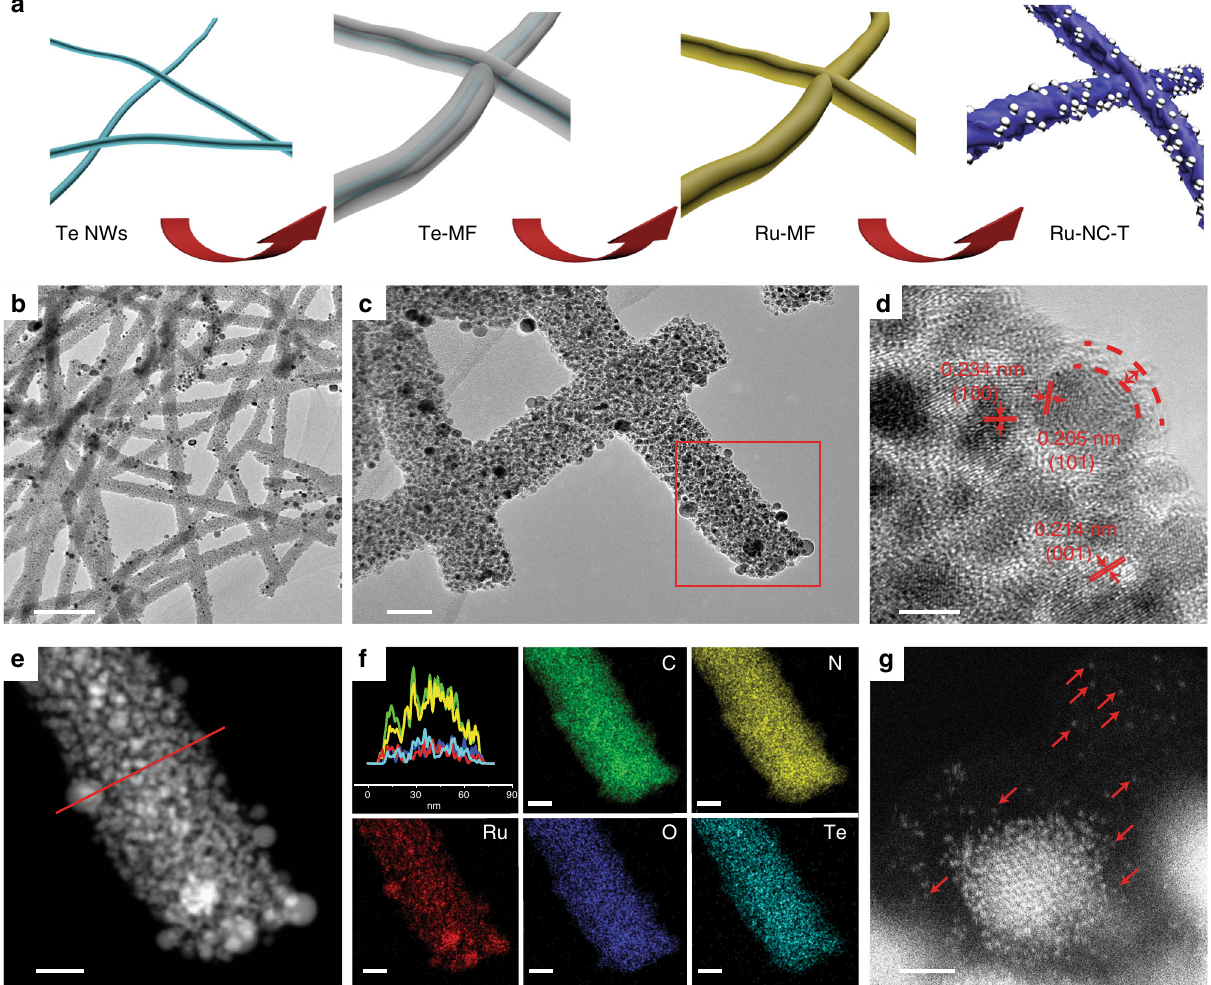
Fig. 1 Schematic of sample preparation and transmission electron microscopic (TEM) studies. a Synthetic procedure of the Ru-NC- T samples. Te NWs denotes tellurium nanowires, Te@MF refers to tellurium nanowires with a melamine – formaldehyde resin shell, Ru-MF indicates the incorporation of ruthenium precursors into Te@MF, and Ru-NC- T signi fi es Ru,N-codoped carbon prepared by pyrolysis of the Ru-MF nanowires at different temperatures. b – d Representative TEM images of Ru-NC-800 at different magni fi cations. Scale bars are b 500 nm, c 50 nm, and d 5 nm. e High-angle annular dark- fi eld scanning TEM image of the red area of c . The scale bar is 20 nm. f Cross-sectional elemental distributions by line scans along the red line in e . The colors of the elemental maps of C, N, O, Te, and Ru correspond to those in the line scan spectra. Scale bars are all 20 nm. g A zoom-in of e , where red arrows signify ruthenium single atoms. The scale bar is